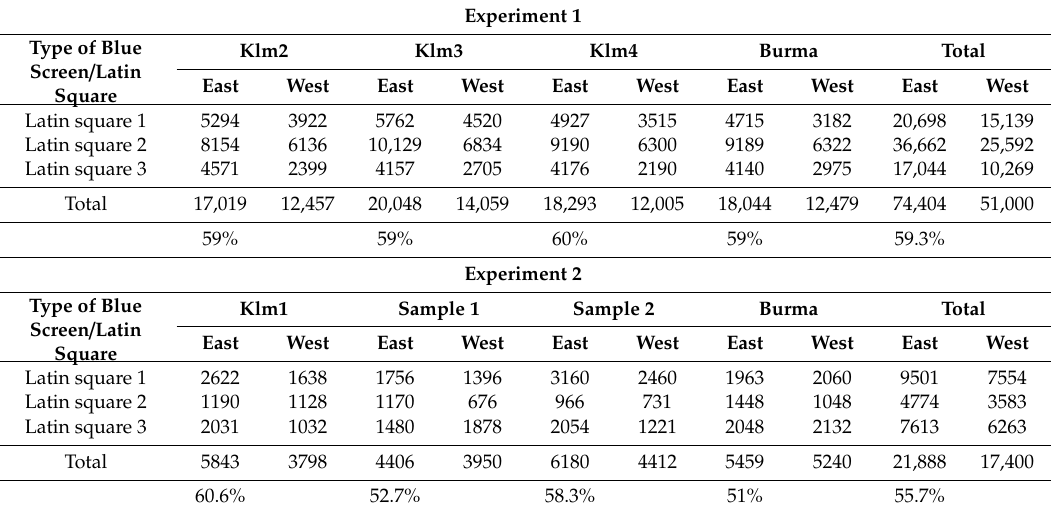
Table 1. Total numbers of Stomoxys calcitrans caught during three sessions of 4 days of trapping according to the east / west sides of the blue screens. In red: percentages of S. calcitrans caught in the east side of a blue screen / total number of stable flies caught on both sides during the entire experiment (total of 12 days of trapping / experiment).